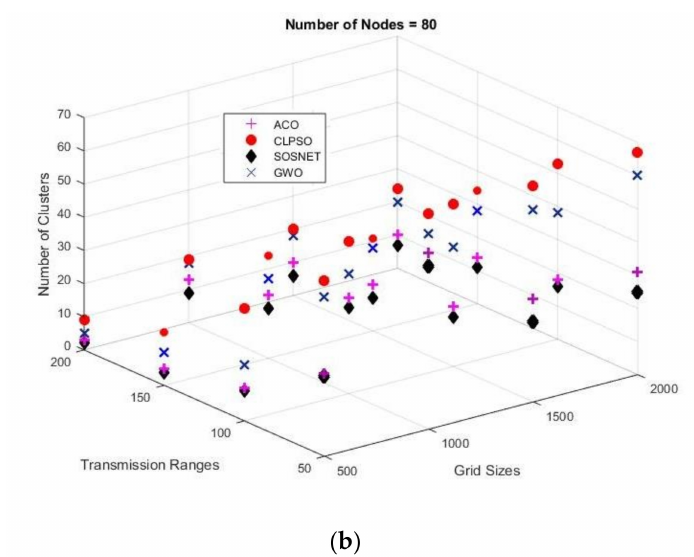
Figure 11. 3D grid, transmission range 50 m to 200 m, grid sizes from 500 m to 2000 m for 40 and 80